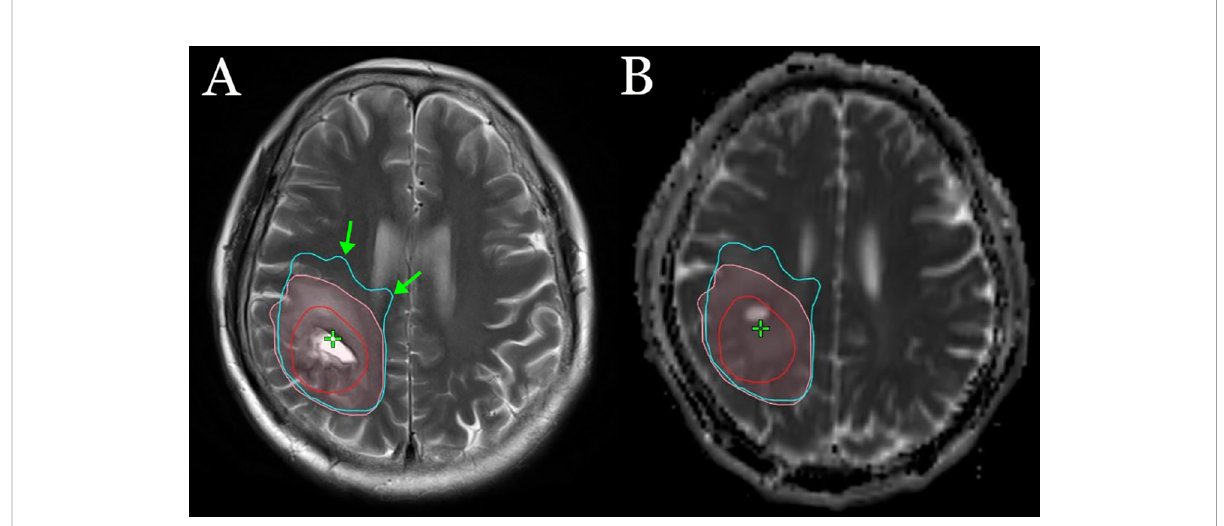
FIGURE 2 An example of the sites of tumor in fi ltration shown by T2 (A) and the DTI-p map (B) . The red line represents GTV, the pink lines represent the sites of tumor in fi ltration shown by T2, and the light blue lines represent the sites of tumor in fi ltration shown by the DTI-p map. The green arrow represents the depth of tumor in fi ltration shown by the DTI-p map was deeper than T2/FLAIR in the direction of adjacent main nerve fi ber